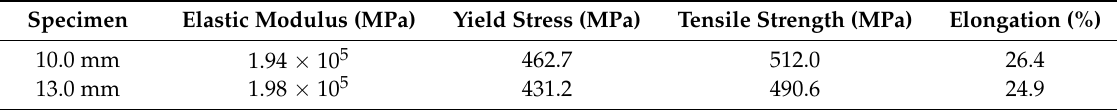
Table 2. Material properties of the stud material.